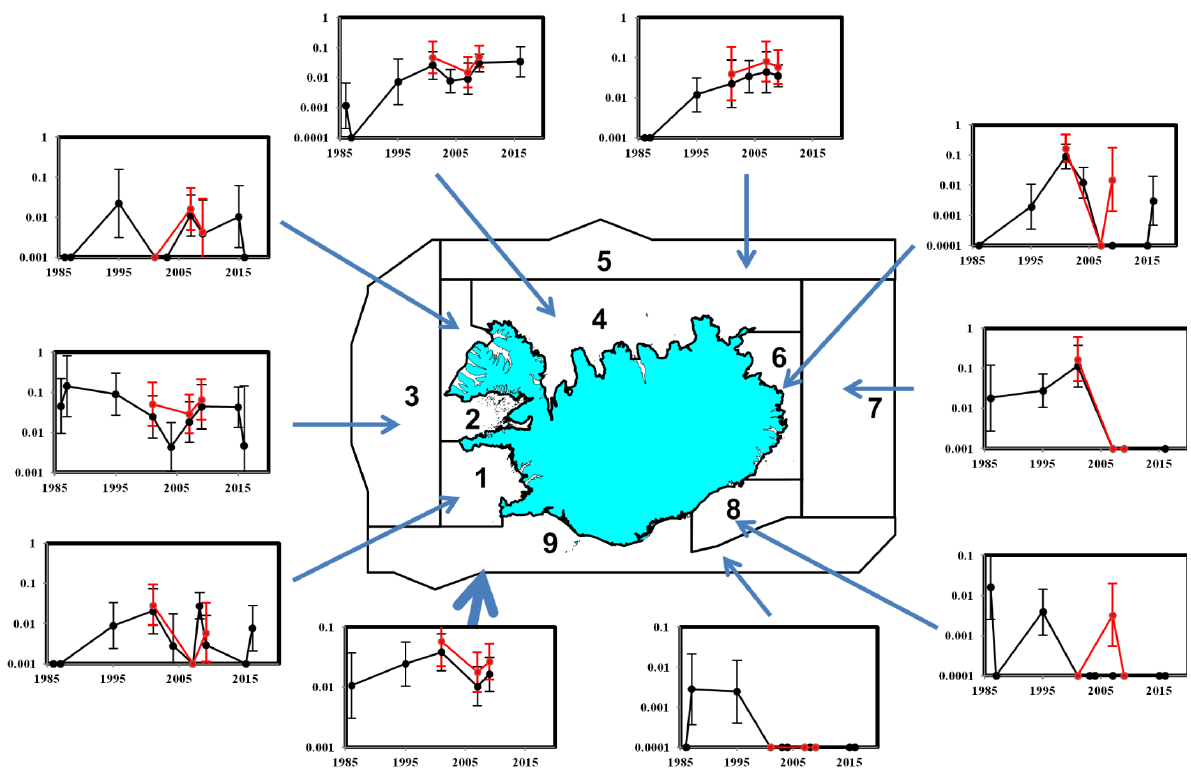
Figure 12. Trends in the relative abundance (black line, uncorrected line transect density, whales nm -2 ) and density corrected for perception bias of humpback whales by stratum and for the entire survey area (thick arrow). Zero values of density are shown as the lowest value on the Y-axis. 95% confidence intervals are